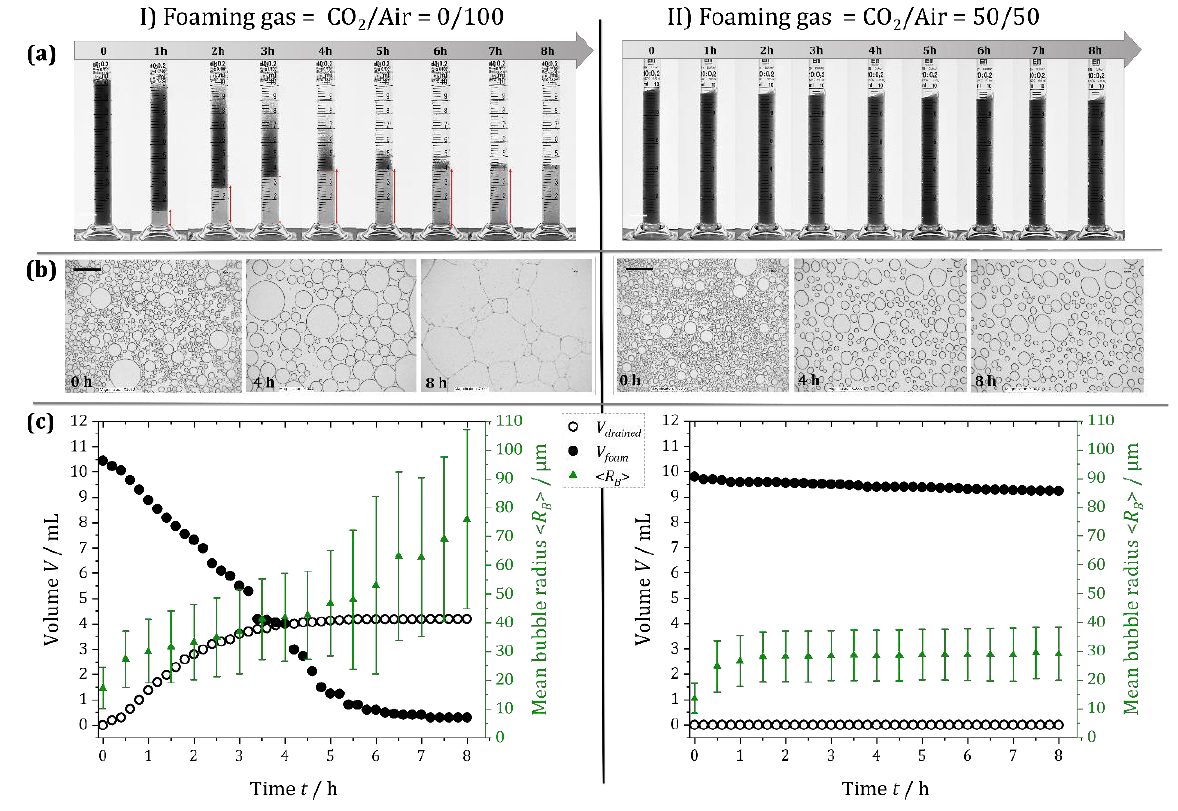
Figure 3. Foam stability of two alginate foams generated with ( I ) CO 2 /air = 0/100 and ( II ) CO 2 /air = 50/50. ( a ) Photographs of the foams taken in closed graduated glass cylinders at 1 h time intervals; the black zone corresponds to the foam, and the transparent zone at the bottom is the drained liquid. ( b ) Microscope images obtained over 8 h after squeezing the foam into a monolayer of bubbles be- tween two glass plates separated by a 34 µm spacer (scale bars 500 µm). ( c ) Temporal evolution of the drained volume of liquid, V drained , and the foam volume, V foam , measured from ( a ), together with the mean bubble radius measured from ( b ). The error bars represent the standard deviation of the bubble sizes measured for each image.